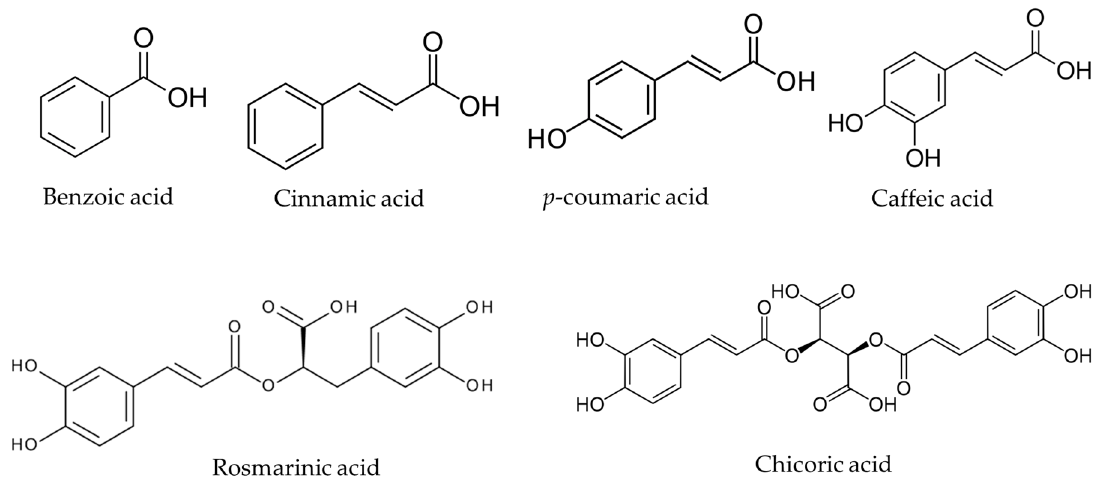
Figure 1. Chemical structures of reviewed natural carboxylic acids (NCA): benzoic acid (BA), cinnamic acid (CinA), p -coumaric acid ( p -CA), caffeic acid (CFA), rosmarinic acid (RA), and chicoric acid (ChA).